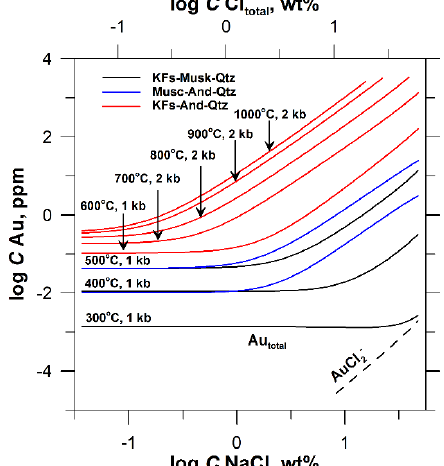
Figure 7. The solubility of Au as a function of fluid chlorinity for S-free system. The concentration of KCl is fixed as m (KCl) = 1/5 m (NaCl). The pH value is controlled by the K-feldspar – muscovite – quartz, muscovite – andalusite – quartz, and K-feldspar – andalusite – quartz buffers. Horizontal segments of the solubility curves correspond to the AuOH° predominance fields. Thermodynamic data for Au– OH complexes are adopted from Akinfiev and Zotov [35].